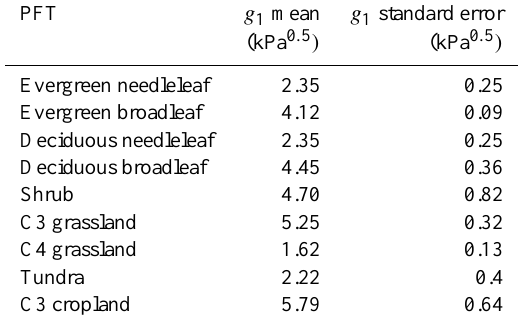
Table 1. Fitted g 1 values based on the CABLE PFTs using data from Lin et al. (2015).